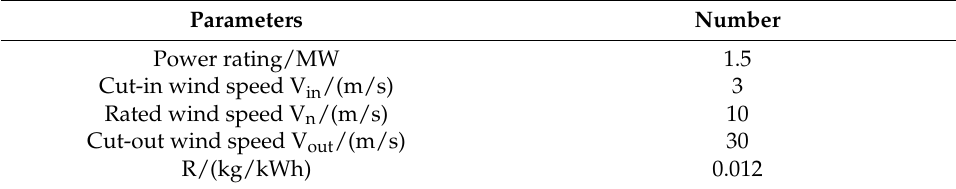
Table A2. Wind turbine parameters.